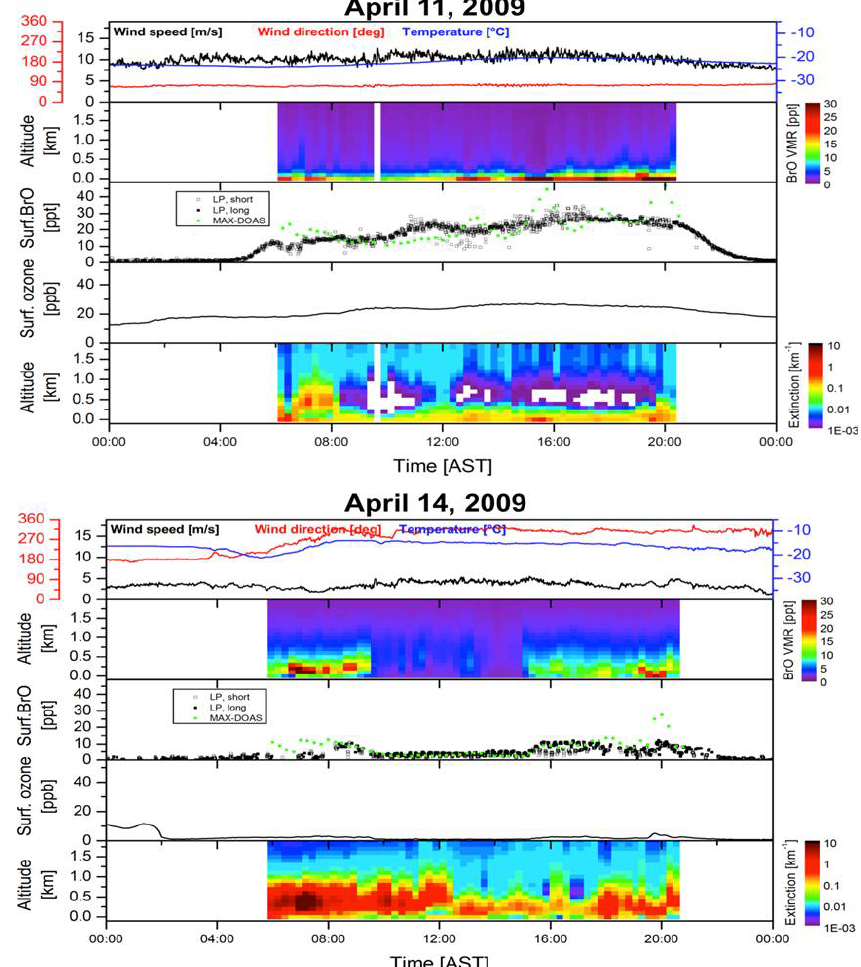
Fig. 8. Vertical profiles for BrO and aerosol optical depth (AOD) at Barrow, AK during OASIS2009 show that in some cases, such as for 11 April, the enhanced BrO is surface-based, while in some cases, the enhancement is aloft (14 April). However, as shown here, in both cases, BrO seems well-correlated with AOD. Figure courtesy of Udo